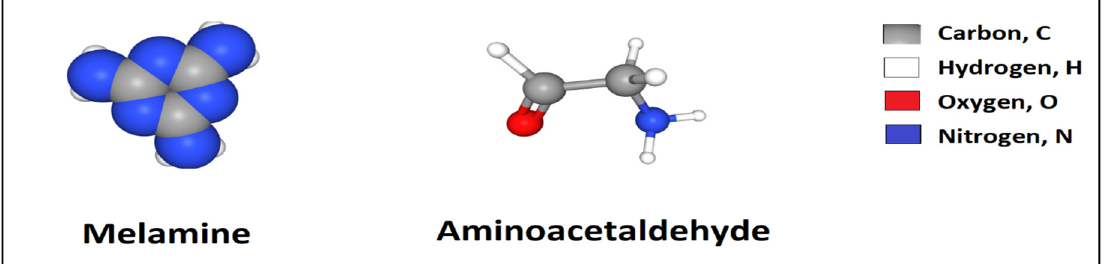
Figure 6. Chemical structure of melamine and aminoacetaldehyde.